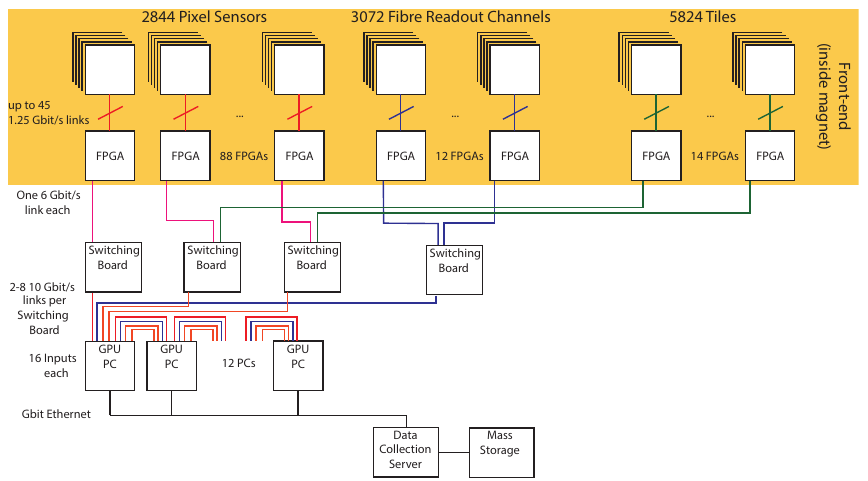
Figure 15. Mu3e DAQ scheme. The data received from the detectors are collected by dedicated front-end FPGAs inside the magnet, then delivered to switching boards where all detector hits are sorted and sent to a PC in the filter farm, where the events are reconstructed